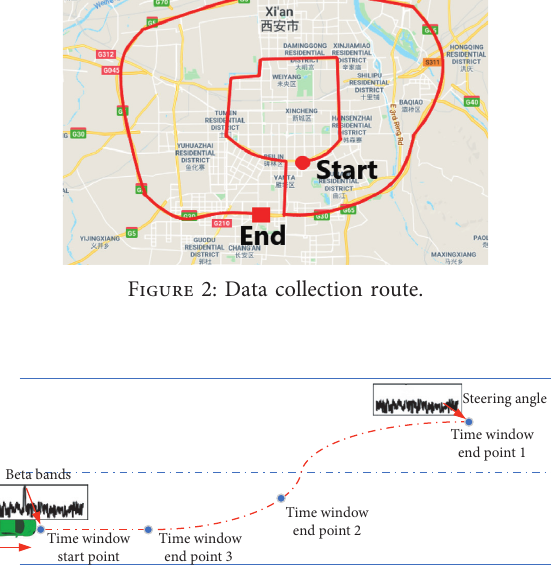
Figure 3: Lane-changing